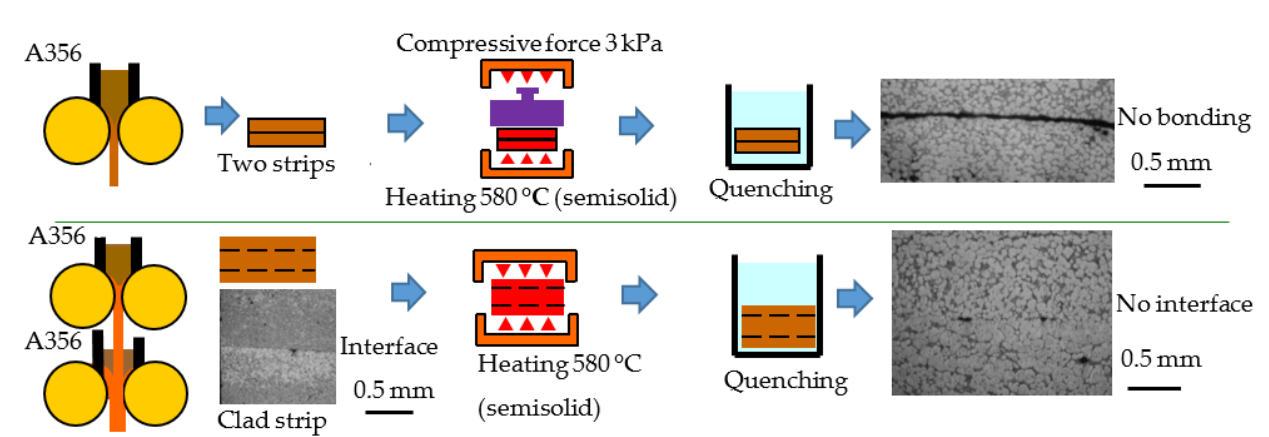
Figure 14. Heating of two stacked A356 strips with compression and three-layer A356 clad strips under semisolid conditions, and images of interfaces between strips.